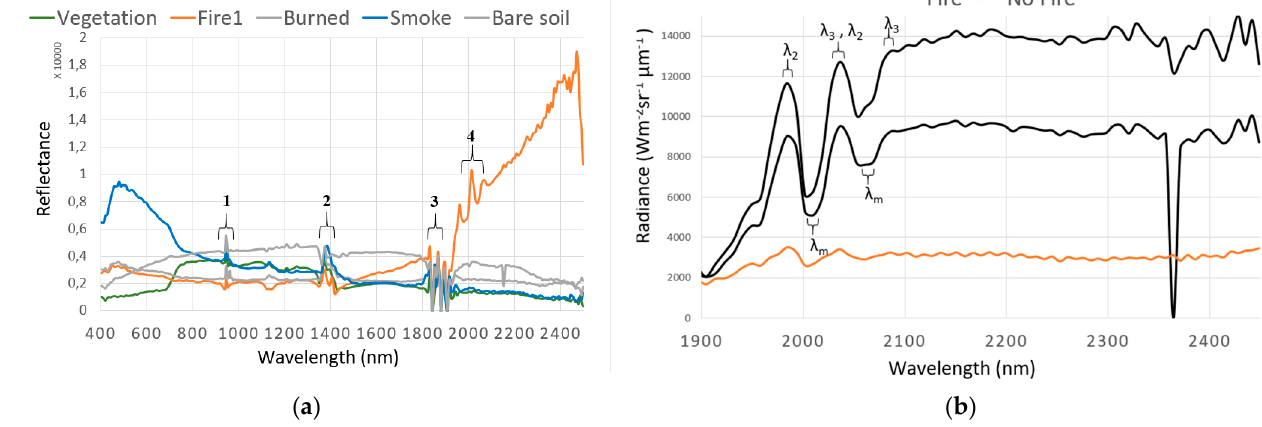
Figure 2. ( a ) PRISMA reflectance spectra corresponding to five categories: vegetation, fire, smoke, bare soil and freshly burned. The black bracket number 1 indicates very near-shortwave infrared (VNIR-SWIR) bands overlapping; the brackets number 2 and 3 indicate atmospheric attenuation from water vapor that can occur at 1400 nm and 1900 nm respectively; the bracket number 4 indicates the CO 2 absorption bands around 2000 nm. ( b ) Two PRISMA fire radiance spectra against the background (no fire) radiance show absorption bands around 2000 nm and 2010 nm ( λ m ) and around 2050 nm and 2060 nm ( λ m ), where CO 2 absorption bands are expected. The positions of the wavelength corresponding to the “shoulders” are indicated as λ 2 (shoulder at the left of λ m ) and λ 3 (shoulder at the right of λ m ), respectively. used to calculate the CO 2 -CIBR are reported in Table 2.